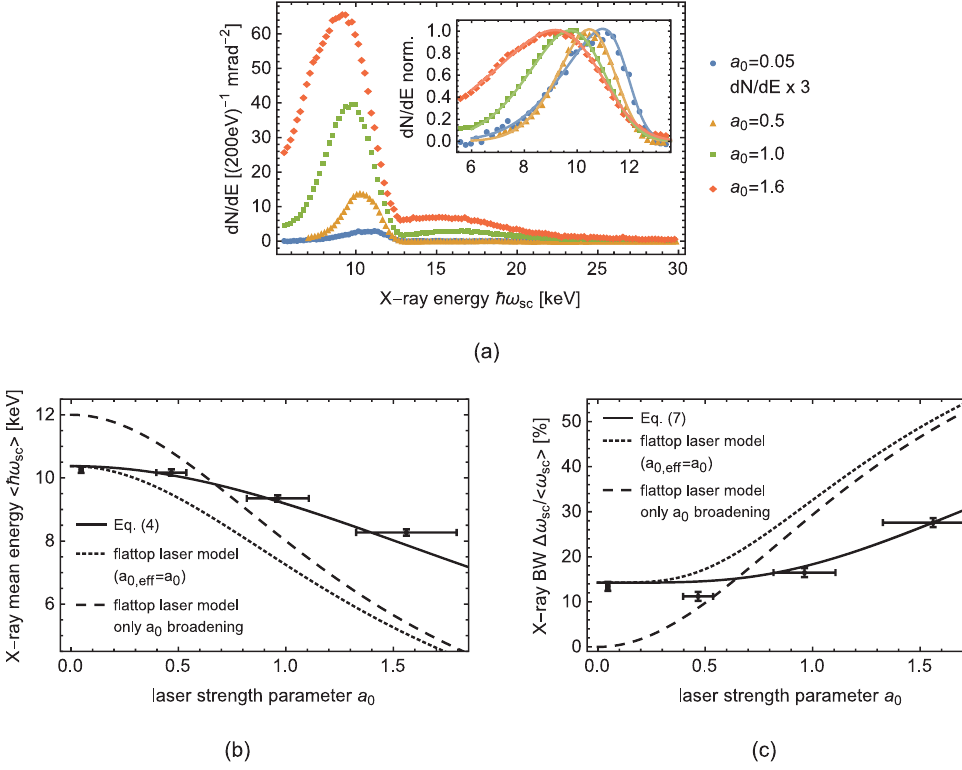
Figure 3. ( a ) Measured ICS spectra for various a 0 . The inset shows the redshift and broadening of the normalized fundamental. Dots represent measurements and solid lines are fitted skew normal distributions to derive mean energy and bandwidth. ( b ) and ( c ) Dependence of mean energy and bandwidth derived from ( a ) on the (peak) laser strength parameter a 0 and comparison to Eqs 4 and 7 for the given setup (solid lines) using a Gaussian laser envelope ( a 0,eff = 0.55 a 0 ). Dotted lines represent the scalings for a flattop laser model with a 0,eff = a 0 and dashed lines neglect other broadening and redshifting effects from e.g. the electron beam emittance. Error bar represent the estimated, combined measurement uncertainty of a 0 and the X-ray detector resolution.